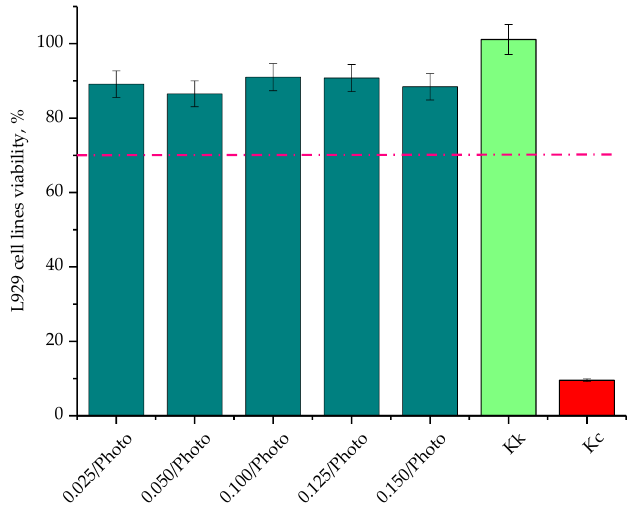
Figure 12. Cytotoxicity of the hydrogels towards L929 murine fibroblasts (the pink dotted line indicates 70% cell viability below which the tested material is considered as cytotoxic).